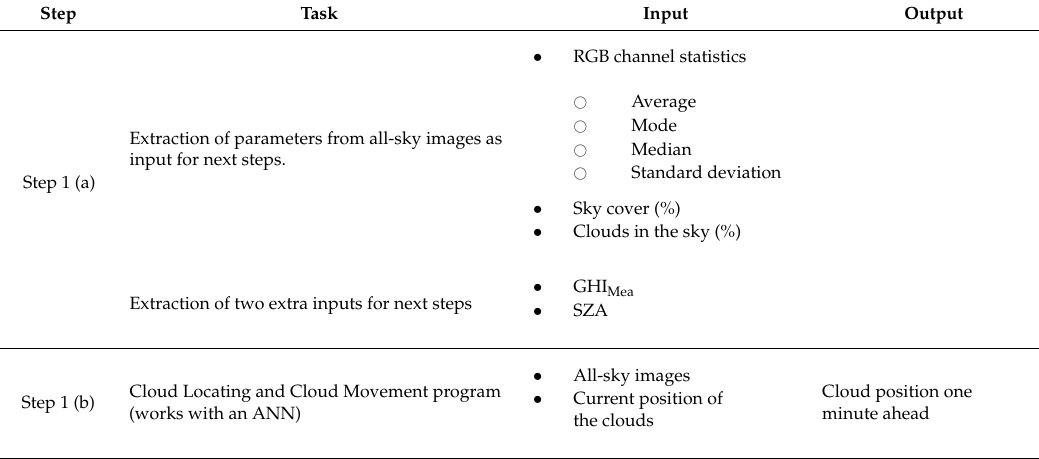
Figure 1. Process of the forecast of the global horizontal irradiance (GHI) with all-sky images and an artificial neural network (ANN). Table 1. Summary of data preparation and methodology. Step I-selected inputs and the Cloud Movement program. Step II-two different ANNs with their respective inputs and output parameters. Step III-comparison of the neural network and the persistence model. The sun zenith angle (SZA) is the angle between the zenith and the centre of the sun’s disc.